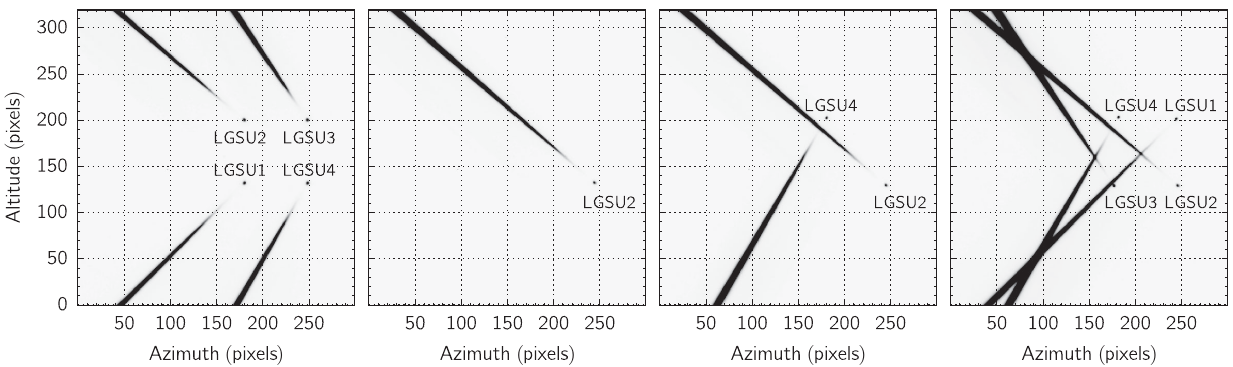
FIG. 5. Images from the LPC (1.29 arseconds per pixel) [55,56] with (from left to right) the 4LGSUs in their nominal MUSE-WFM asterism (radius of about 62 arc sec), LGSU2 at the position of LGSU4, LGSU2 and LGSU4 at each other ’ s default positions, and all LGSU positions swapped (LGSU 1 → LGSU 3 , LGSU 2 → LGSU 4 , LGSU 3 → LGSU 1 , and LGSU 4 → LGSU 2 ). The off-axis location of the LPC (on the UT4 top ring) gives rise to the peculiar perspective of the crossed configurations.